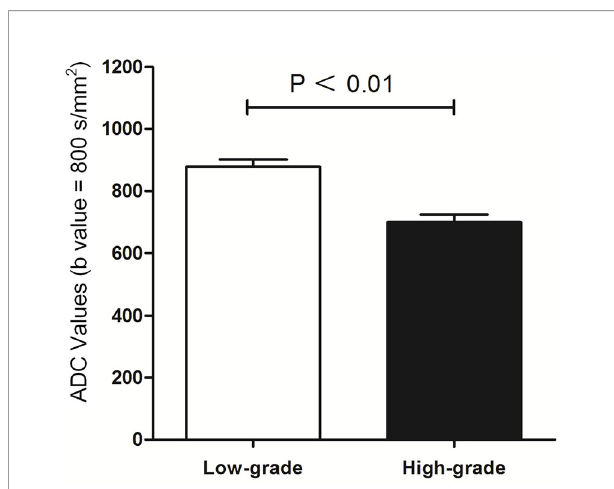
FIGURE 5 | Comparison between histological low-grade and high-grade urothelial cancer according to ADC value